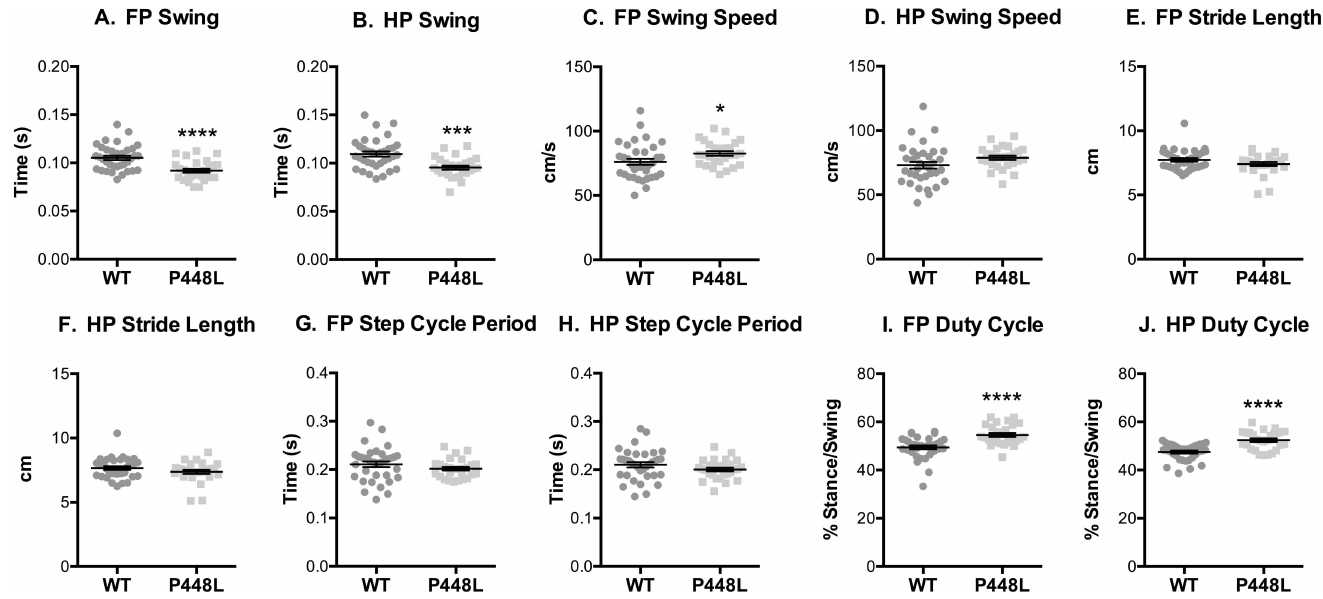
Fig 2. Gait Cycle. (A,B) Fore paw and hindpaw measurements of the time paws are airborneand (C,D) the speed at which paws are moving. (E,F)The totaldistancetravelled by the paw duringswing. (G,H)The timeit takes frominitial paw contactwith the ground fromone step to the initialpaw contactof the precedingstep. (I,J)The proportionof timethat the paw spends on the ground comparedto in the air. (FP = fore paw, HP = hindpaw, n = 12; * p < 0.05; *** p (cid:20) 0.001, **** p (cid:20) 0.0001).